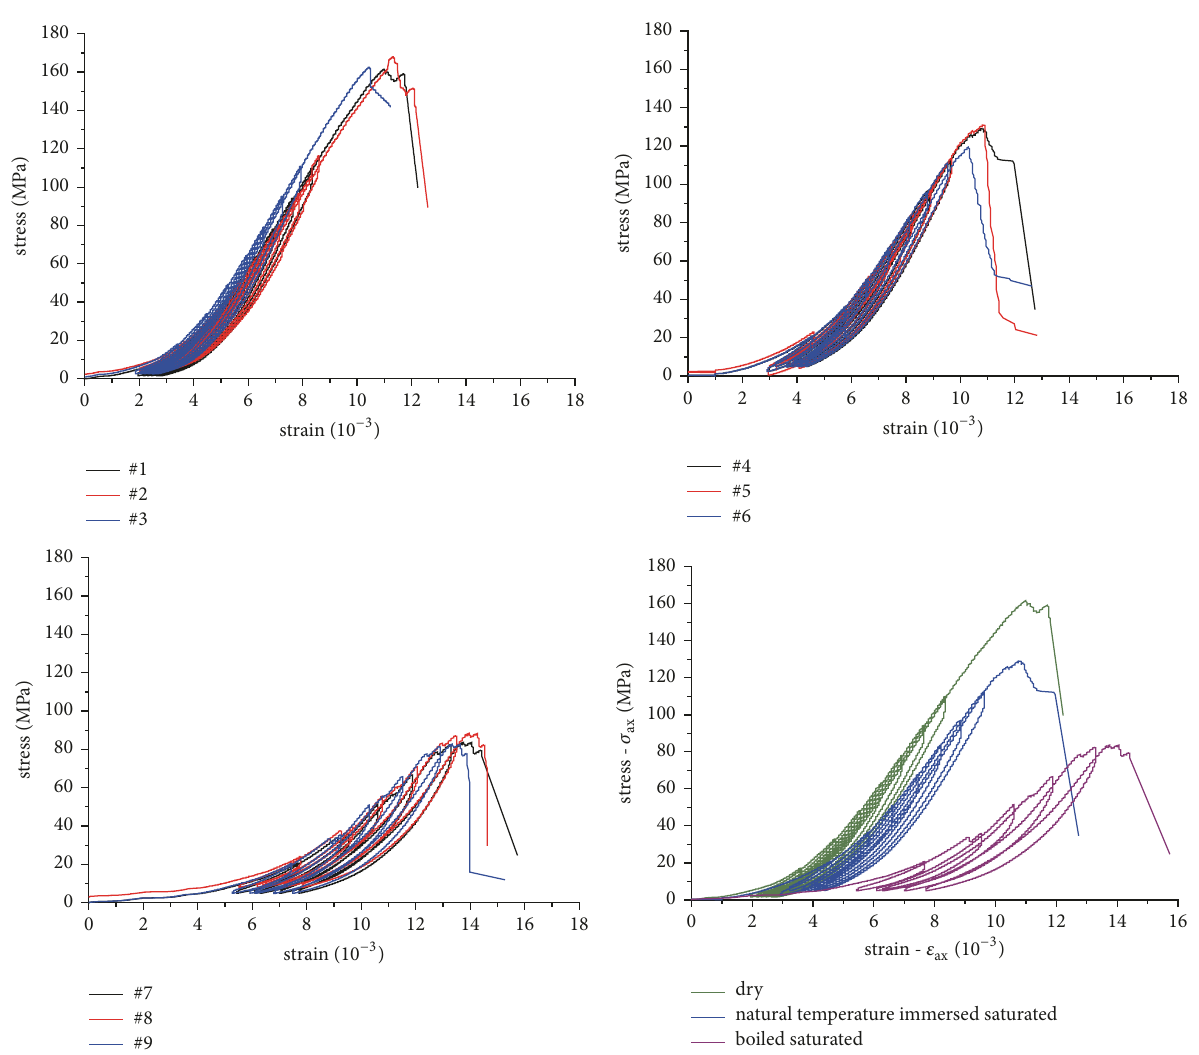
Figure 7: Axial stress and strain curves of the different water content samples from incremental cyclic loading